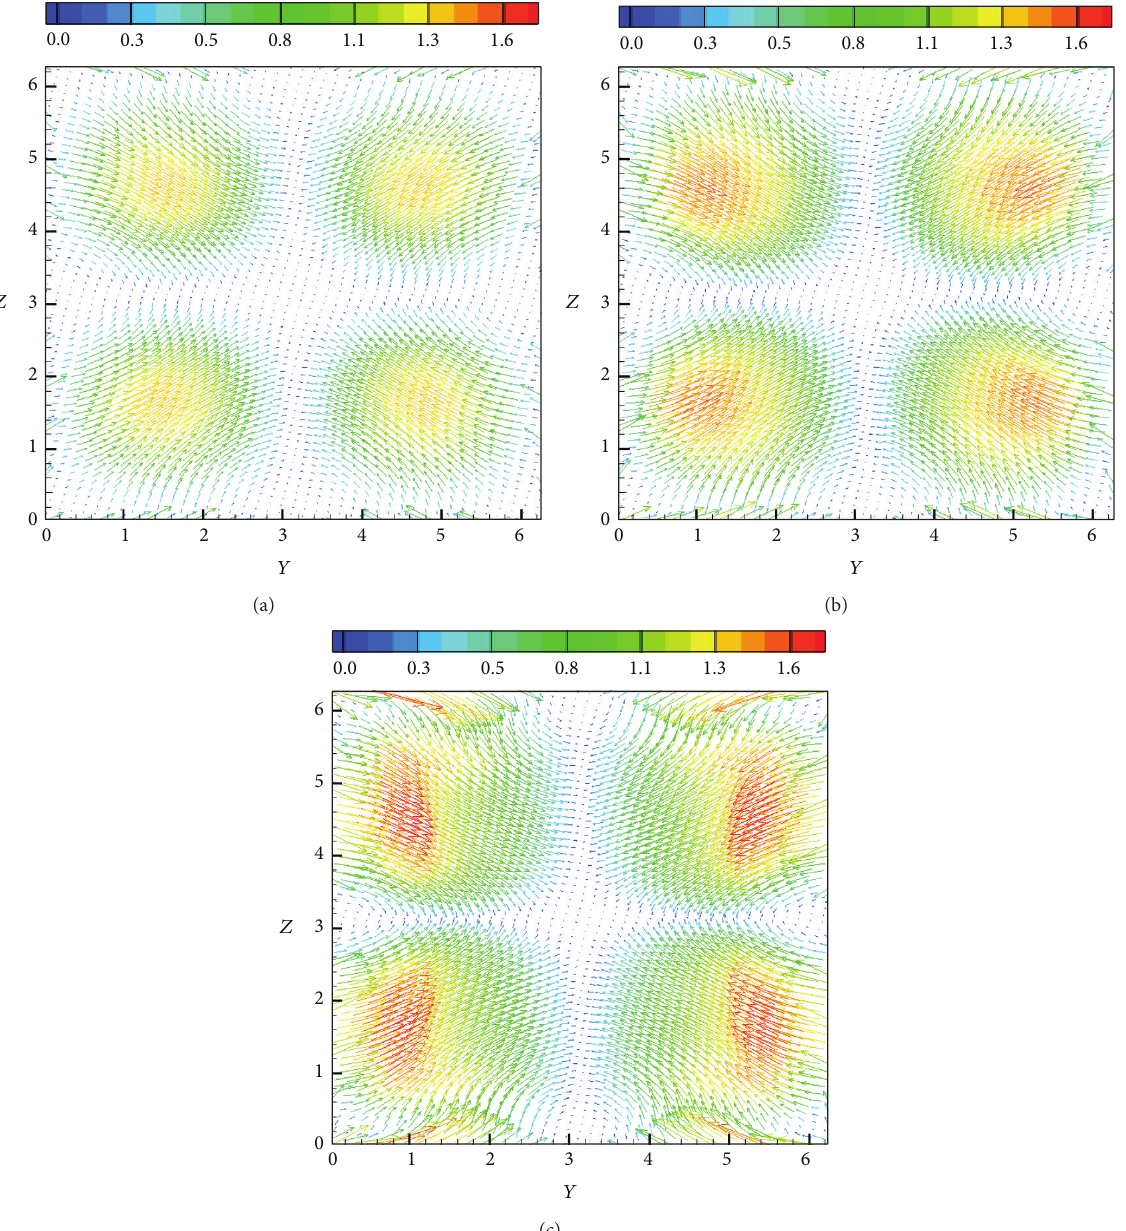
Figure 15: Instantaneous slices across the 𝑥 -direction centerline ( = 𝜋 ) showing vectors of the 2 D magnetic field ( 𝐵 𝑦 , 𝐵 𝑧 ) colored by the magnitude of the magnetic field at (a) 𝑡 = 0.2 , (b) 𝑡 = 0.4 , and (c) 𝑡 = 0.8 (grid: 256 3